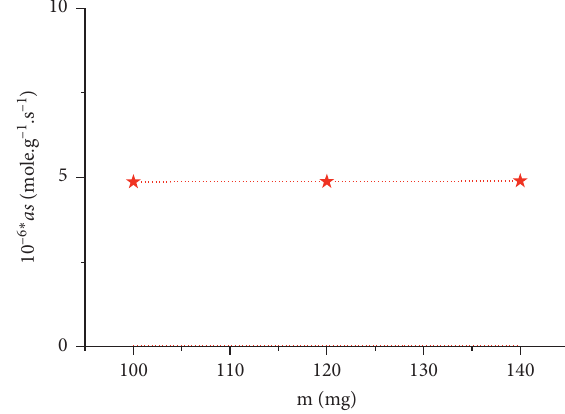
Figure 4: Mass effect on the isopropanol